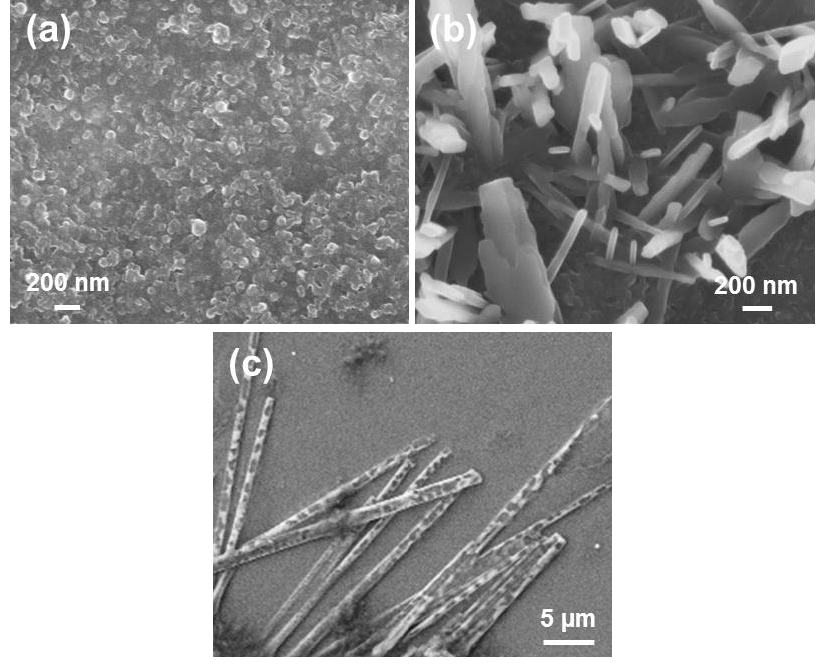
Figure 10. SEM micrographs of the structures obtained from Fmoc-FFFF solutions in ( a ) 1:49 HFIP:water (0.1 mg/mL), ( b ) 1:9 HFIP:water (0.5 mg/mL), and ( c ) 3:47 HFIP:EtOH (0.3 mg/mL). (0.1 mg / mL), ( b ) 1:9 HFIP:water (0.5 mg / mL), and ( c ) 3:47 HFIP:EtOH (0.3 mg /